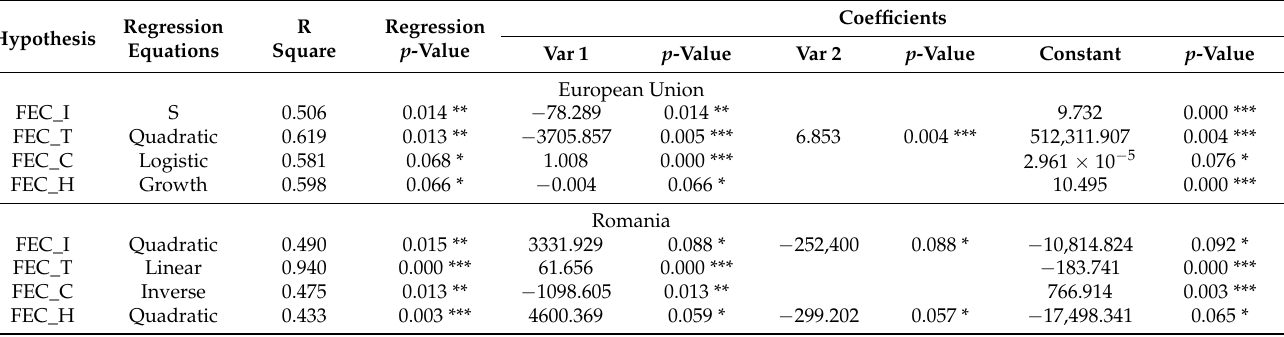
Table 4. Estimation of parameters of the most suitable equations for estimating the relationship between GDP and FEC by sector.